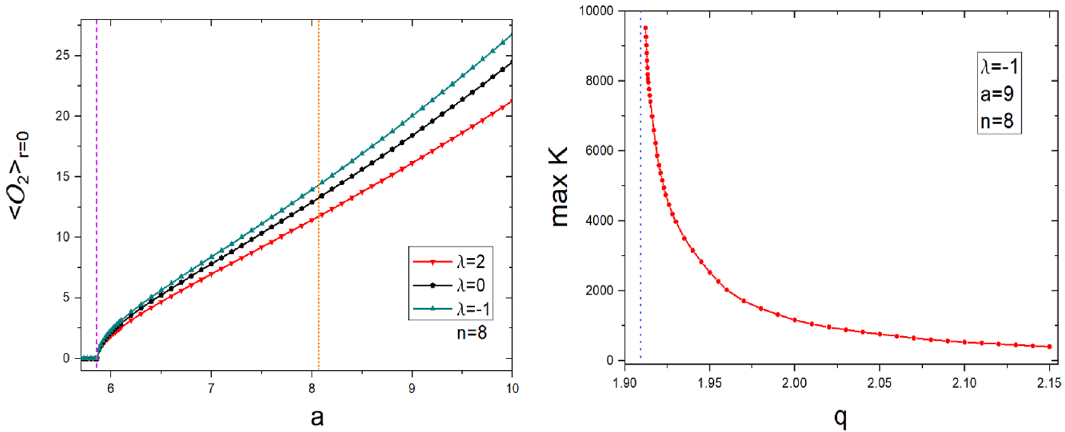
Figure 3 . Left : scalar condensate hO 2 i at r = 0 against a at fixed q = 2 . 15 for λ = − 1 , 0 , 2 . The purple dashed vertical gridline corresponds to a = 5 . 86 while the orange dotted one to a max = 8 . 06 . Right : the maximum K over spacetime against scalar charge q , computed with λ = − 1 and a = 9 . The vertical gridline marks q min = 1 . 909 . Both panels take n = 8